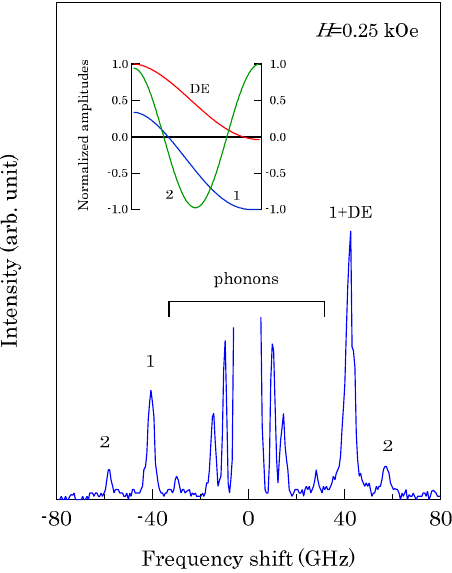
Figure 6. BLS spectrum observed from an epitaxial 1010 Co thin film 45 nm thick at room tem‑perature. Because no polarization selection has been done, scattering from SWs and SAWs was observed. The structure labeled “phonons” within ±30 GHz around the elastic RS peak was due to SAWs. These were assigned to the Rayleigh wave and the first and second order Sezawa waves with increasing frequency. SW peaks up to the second order SSW appeared above ±40 GHz. Note that the phonon peak intensities are symmetrical for the Stokes and anti-Stokes peaks. On the other hand, the SW peaks were asymmetric. The insert shows calculated n = 1 ( − ) and 2 ( − ) SSW and DE mode ( − ) profiles [60]. For clarity’s sake, I display the profiles of the DE mode localized on the top surface and the SSW modes for the bottom surface.